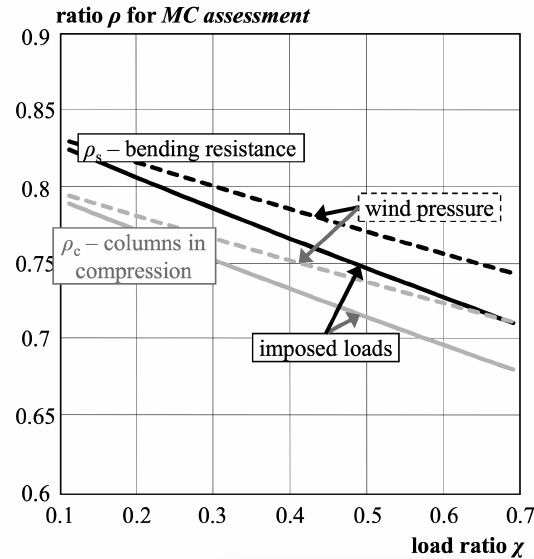
Figure 4. Variation of ratio ρ for MC assessment